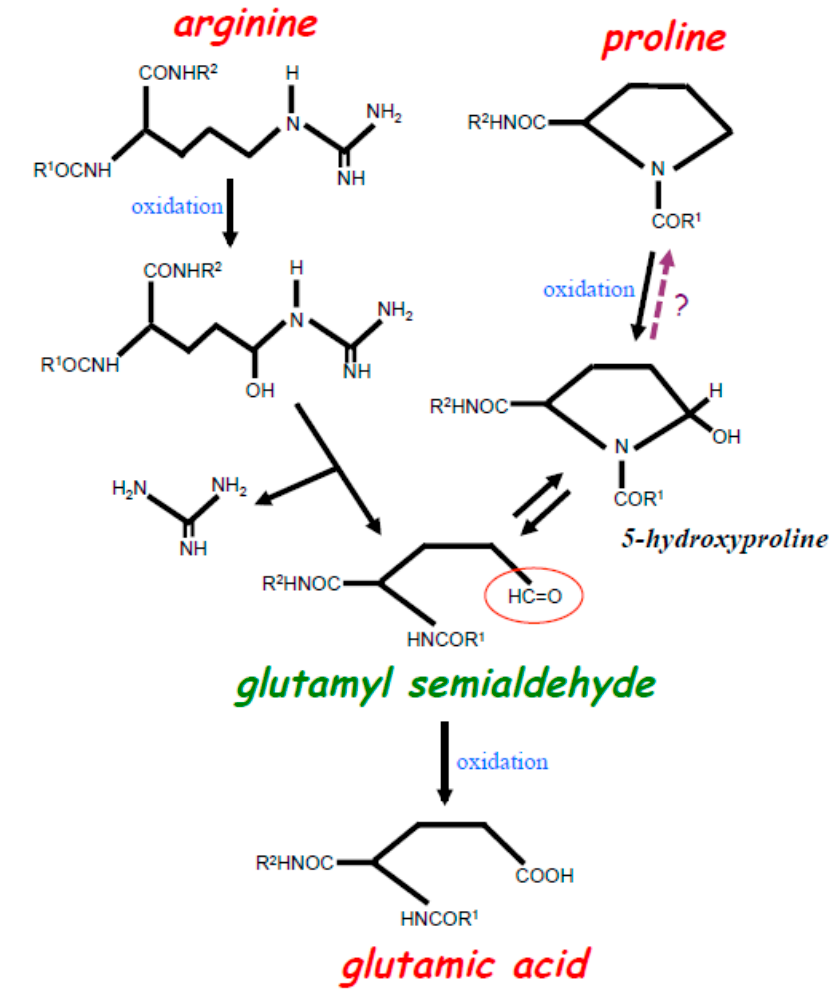
Figure 1. Scheme depicting the oxidation of Arg and Pro residues in the protein structure. Iron-catalyzed oxidation of both Arg and Pro residues results in the formation of glutamyl semialdehyde with a carbonyl group (red circle). Oxidation of Arg results in the loss of a bulky amino group-containing structure during the formation of glutamyl semialdehyde. Oxidation of Pro first forms 5-hydroxyproline, which is further oxidized into glutamyl semialdehyde. Studies of purified proteins indicate that the oxidation of Pro to 5-hydroxyproline is irreversible, yet our experiments with live cells suggest that this reaction may be reversible (as indicated with?). Glutamyl semialdehyde can further be oxidized into Glu.